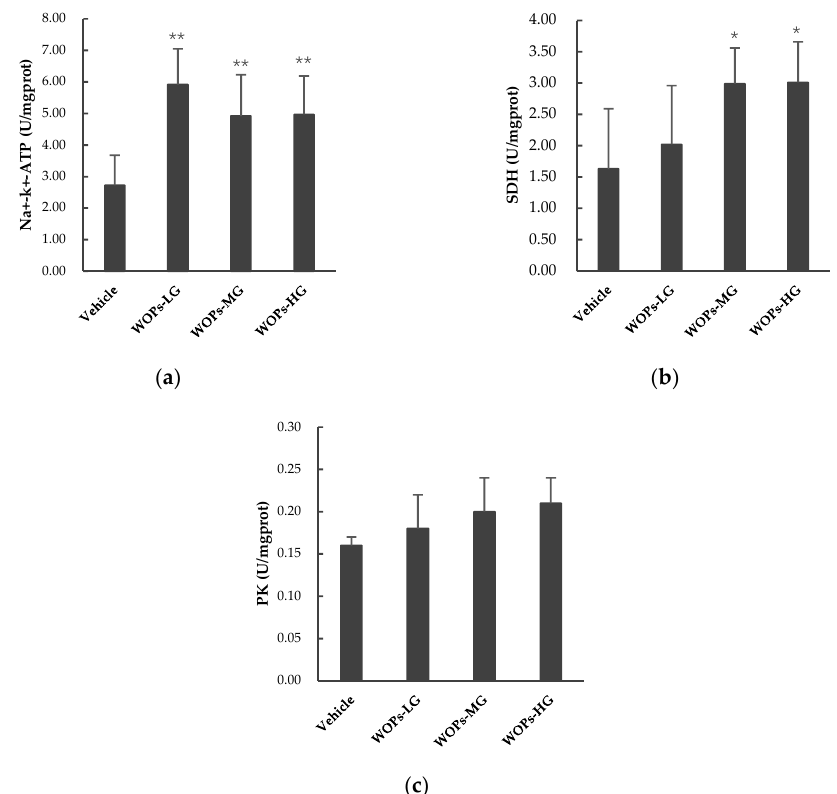
Figure 4. The regulation effects of WOPs on the activity PK, SDH, and Na+-K+-ATPase in the skeletal muscle of mice. ( a ) Na+-K+-ATPase; ( b ) pyruvate kinase (PK); ( c ) succinate dehydrogenase (SDH). Values are expressed as mean ± SD ( n = 10). * p < 0.05, ** p < 0.01 mean significant difference versus vehicle group. WOPs-LG, walnut oligopeptides low-dose group at a dose of 110 mg/kg; WOPs-MG, walnut oligopeptides medium-dose group at a dose of 220 mg/kg; WOPs-HG, walnut oligopeptides high-dose group at a dose of 440 mg/kg.